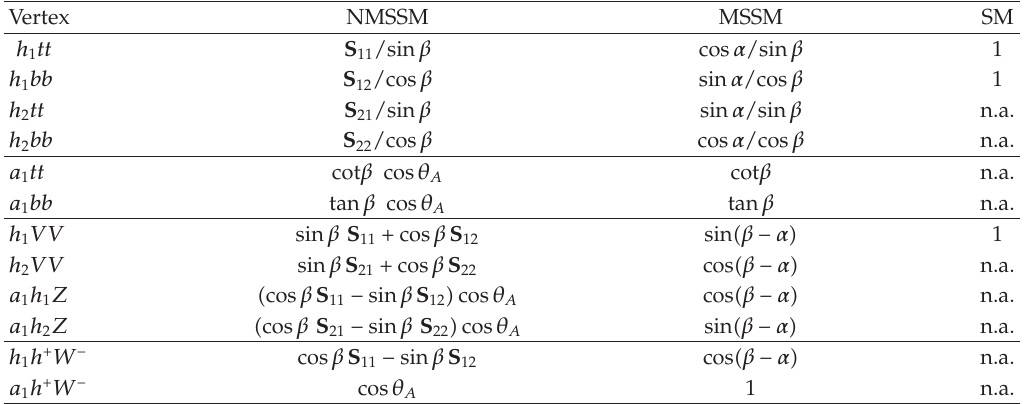
Table 1: Reduced Higgs couplings in the NMSSM compared to the MSSM and the SM (cid:2) when applicable (cid:3) . Note that the reduced couplings to fermions are identical for all three generations, even if only the third generation is displayed here. The couplings to h 3 can be obtained from the h 1 ones by the replacements S 11 → S 31 and S 12 → S 32 whereas the couplings to a 2 can be obtained from the a 1 ones by the replacement cos θ A → sin θ A